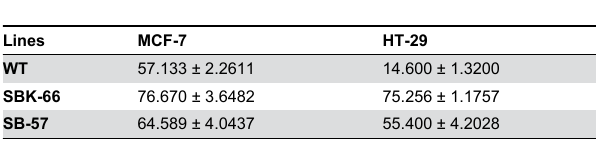
Table 1. Percentage of inhibition effects of T2 rice- produced rhIGFBP-3 on MCF-7 and HT-29 cells.